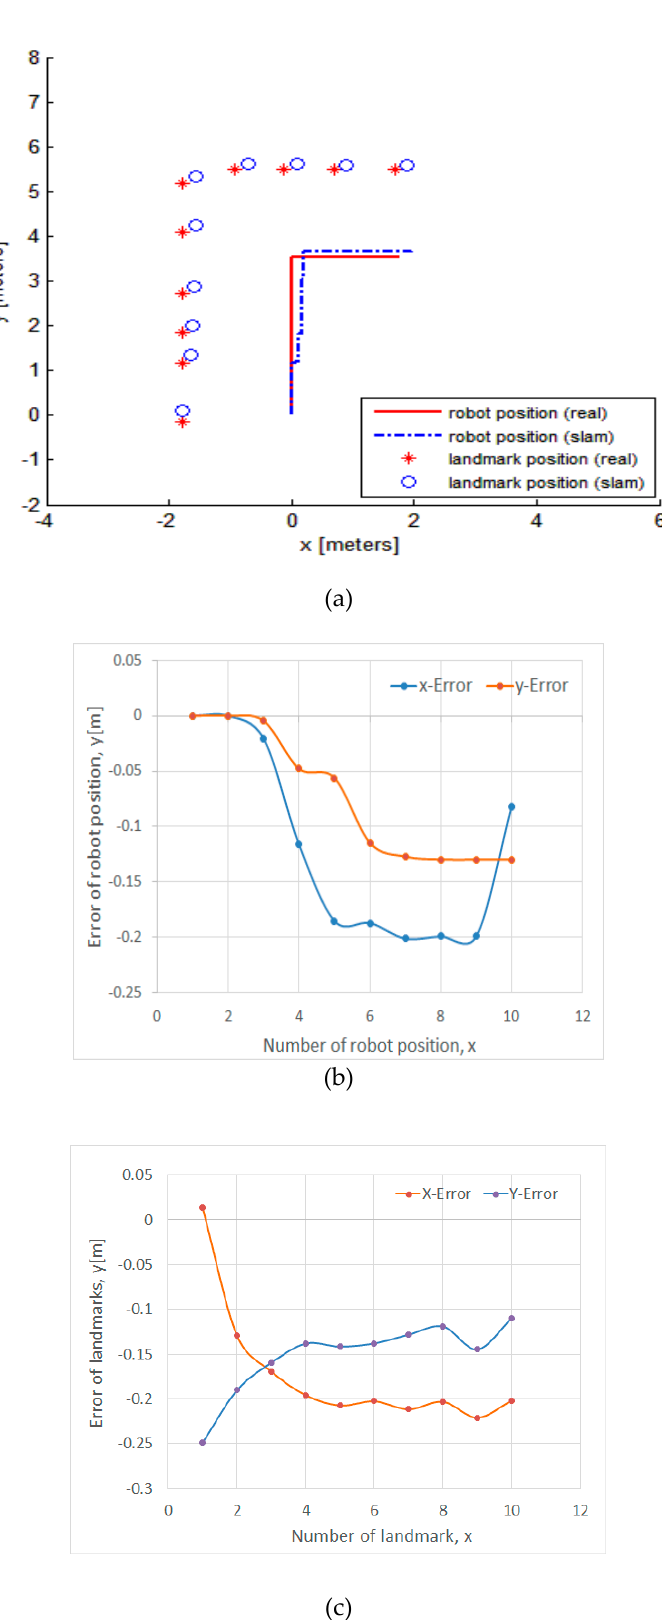
Figure 18. Experimental result of acoustic EKF-SLAM based on microphone landmark observations: ( a ) EKF-SLAM for a mobile robot based on microphone landmark observations; ( b ) robot’s position errors in the x - and y -directions; and ( c ) landmark position errors in the x - and y -directions.